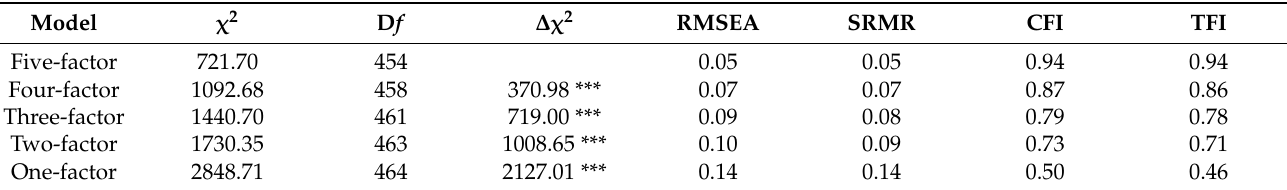
Table 3. Confirmatory Factor Analyses Results.